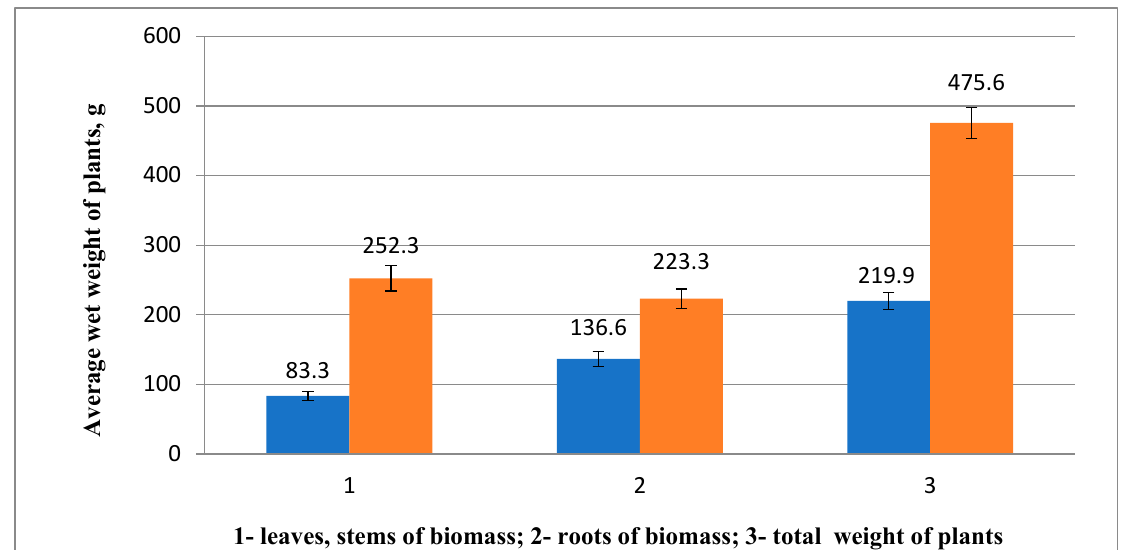
Figure 7. Vermicompost influence on the S. tau-saghyz fresh weight.